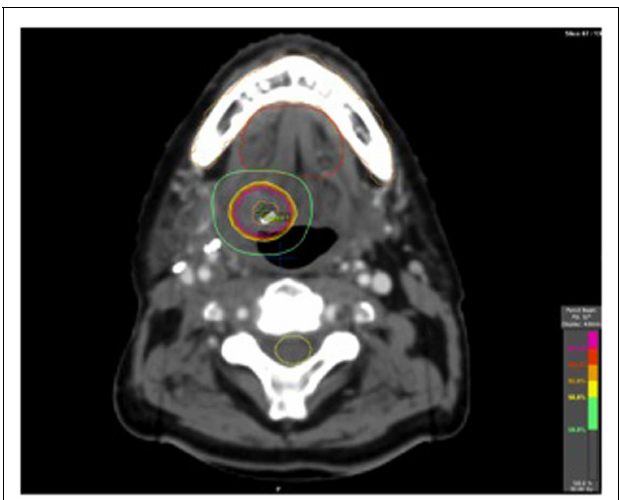
1.8 Gy. The total time elapsed was 6 weeks. On restaging PET,